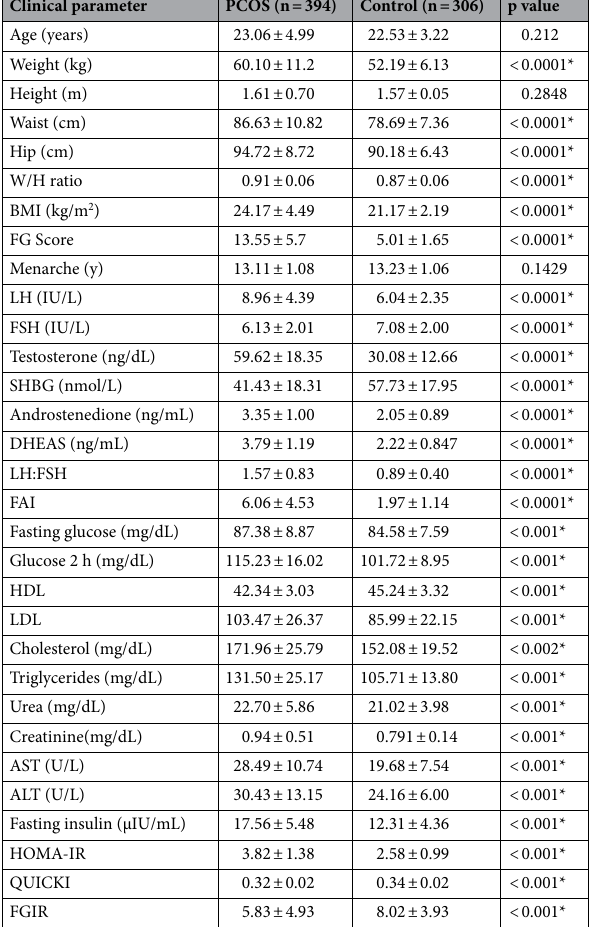
Table 1. Anthropometric data of study participants. Data presented as mean ± SD. *p-value < 0.05 significant. p values calculated by Independent Student’s t test. PCOS polycystic ovary syndrome, BMI body mass index,